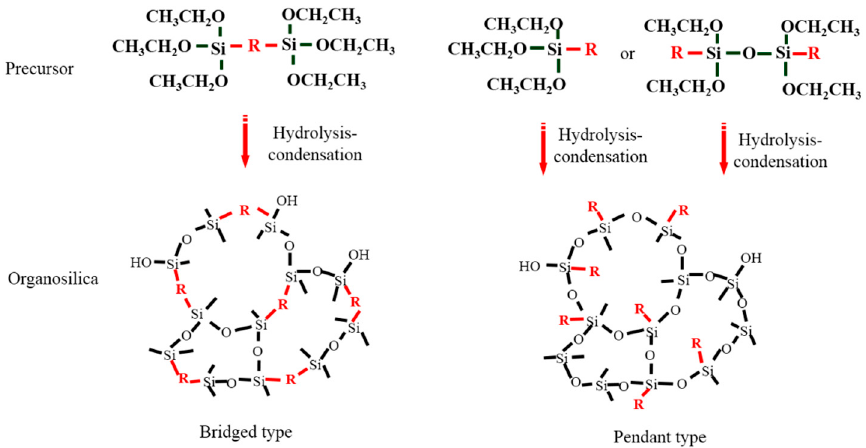
Figure 2. The represented bridge-type and pendant-type precursors and their organosilica structures formed (R: organic groups).